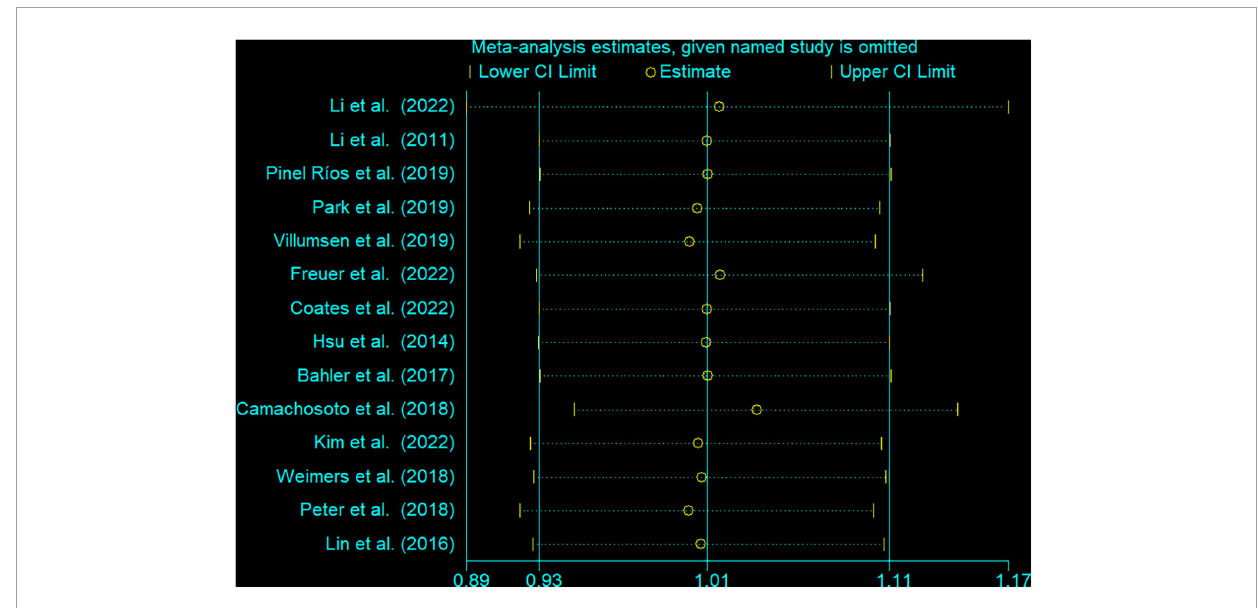
FIGURE3 Sensitivity analysis for the association between inflammatory bowel disease and the risk of Parkinson’s disease. The two ends of the lines represent the 95% CI.